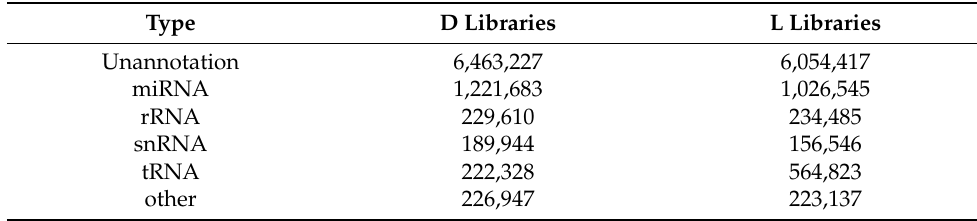
Table 1. Statistics of the classification of the small